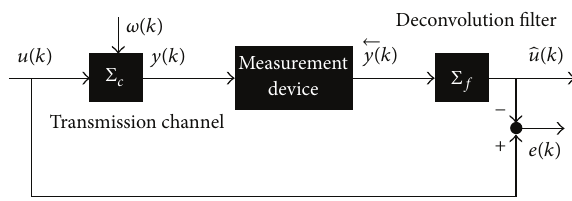
Figure 1: The deconvolution filtering